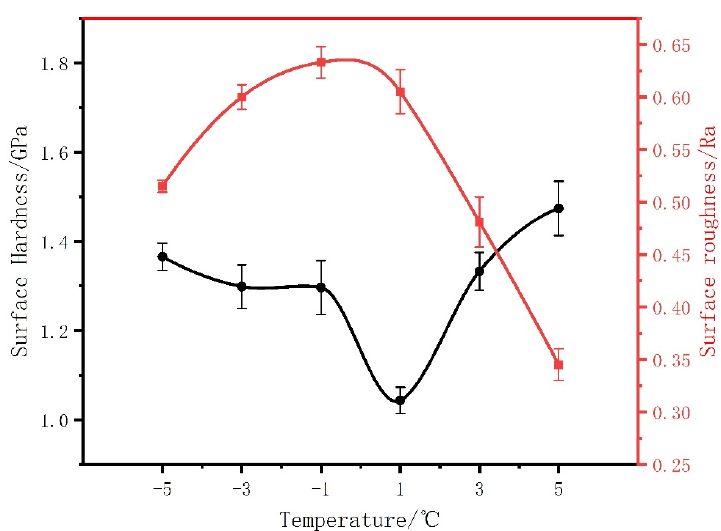
Figure 7. Surface hardness and roughness of the copper deposits produced at different temperatures from − 5 ◦ C to 5 ◦ C. Among them, the surface hardness of the copper deposit layer fluctuates most from − 5 °C to 5 °C. Among them, the surface hardness of the copper deposit layer fl uctuates most obviously at 1 ◦ C, and is as low as 1 GPa. obviously at 1 °C, and is as low as 1GPa.